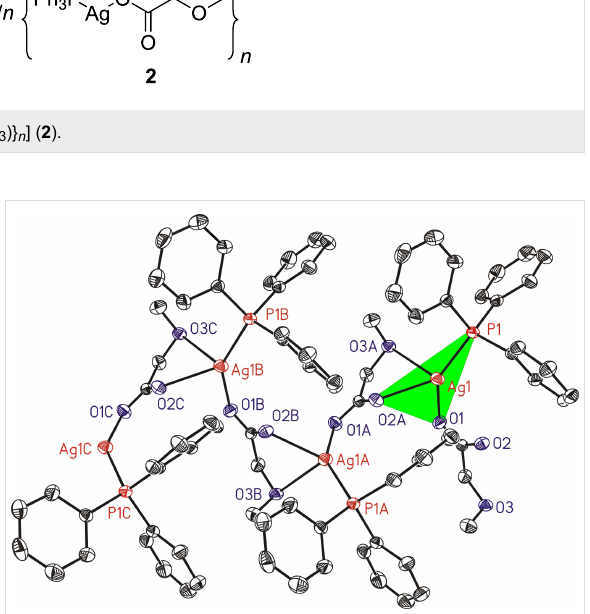
Figure 1: ORTEP (30% probability ellipsoids) of a selected part of the 1D coordination polymer formed by 2 in the solid state. All hydrogen atoms are omitted for clarity. The green triangle indicates the almost planar AgPO 2 coordination units of the silver(I) ions of 2 on a selected case. Symmetry used: “A” = x , – y , – 1 / 2 + z . “B” = x , y , – z + 1 / 2 . “C” = x, – y , – 3 / 2 + z . Selected bond lenghts (Å) and angles (°):